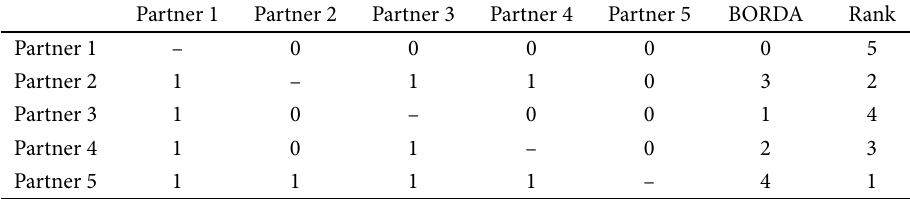
Table 19. Borda method for five